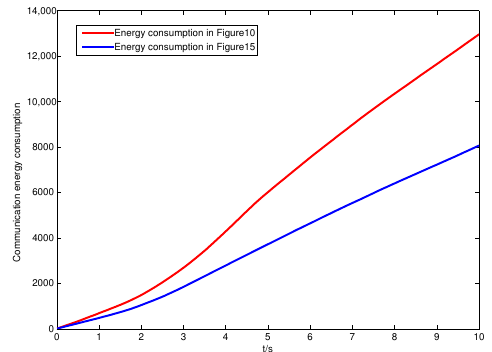
Figure 16. The energy consumption comparison between the two network